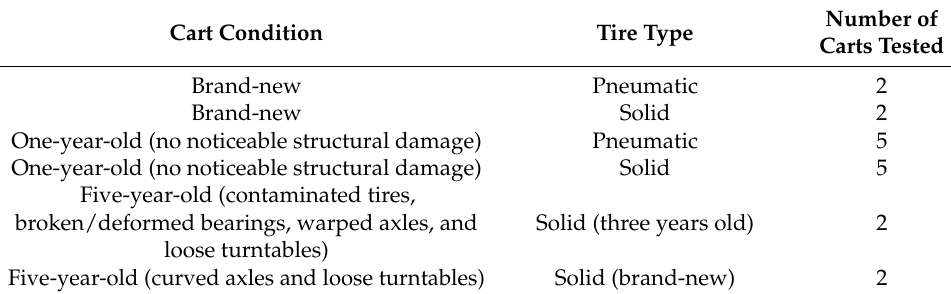
Figure 1. Instrumented cart .